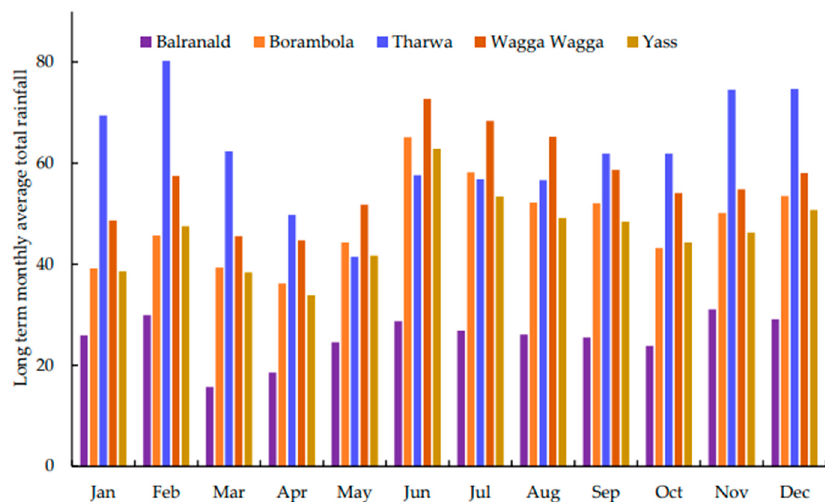
Figure 3. Long-term (1985–2016) historical monthly average rainfall plotted against five different sub-catchments.